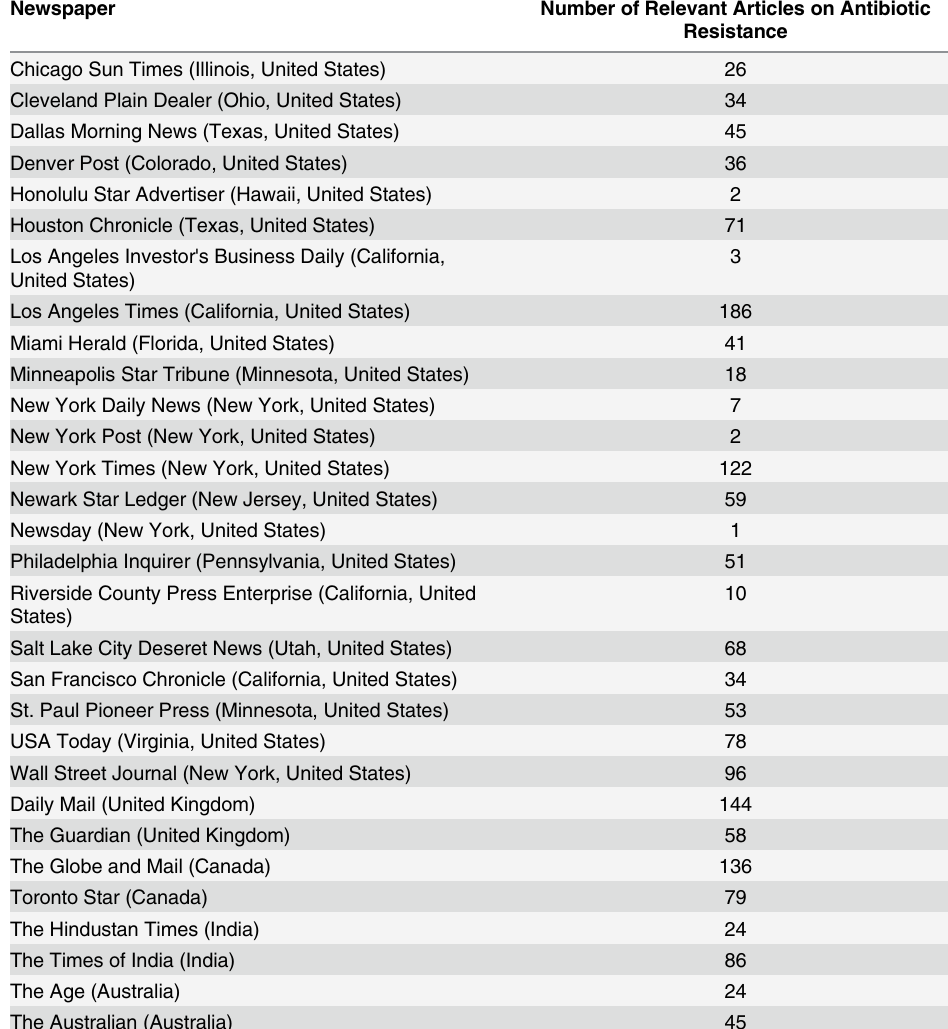
Table 1. Number of Relevant Articles Examined for Each Newspaper.